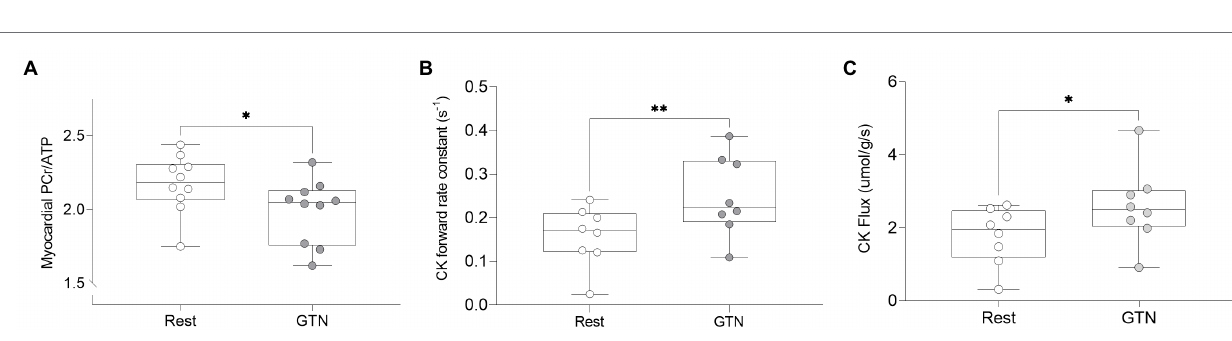
FIGURE 2 | Hemodynamic values at rest and during GTN infusion (values averaged over 5 min). * p < 0.05 and **** p <